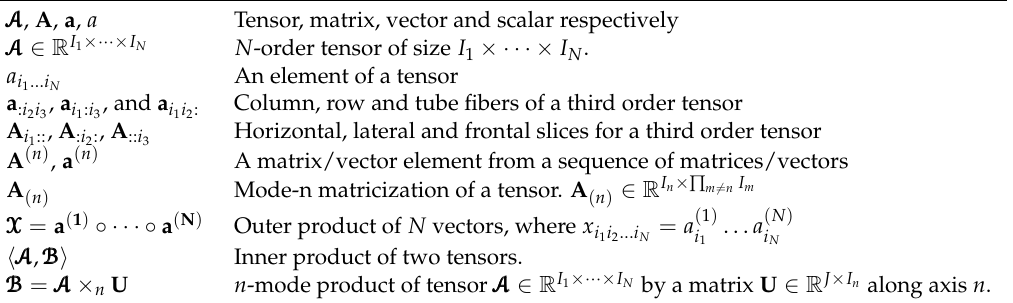
Table 2. Tensor algebra notation